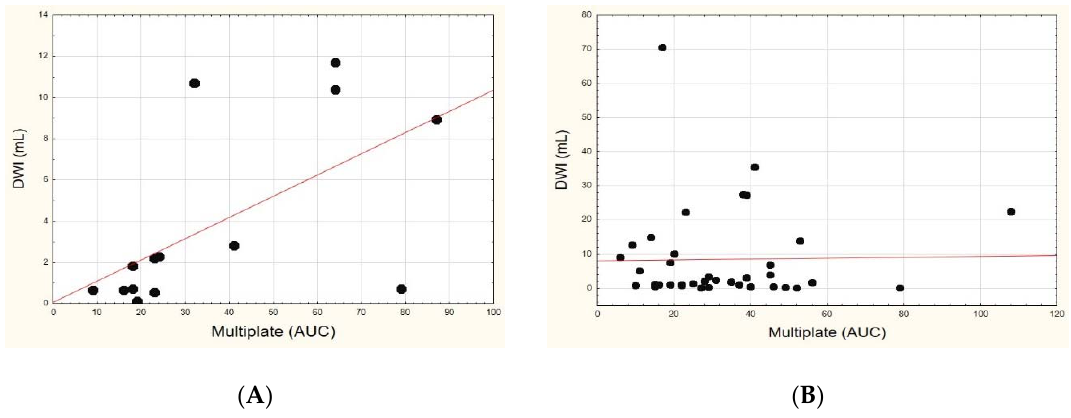
Figure 3. Correlation between platelet reactivity as assessed by Multiplate method (in area under the curve (AUC) units) with the ischemic focus size assessed in diffusion ‐ weighted imaging (DWI) (in mL) sequence in the large-artery atherosclerosis subgroup ( A ) and small-vessel disease subgroup ( B ).